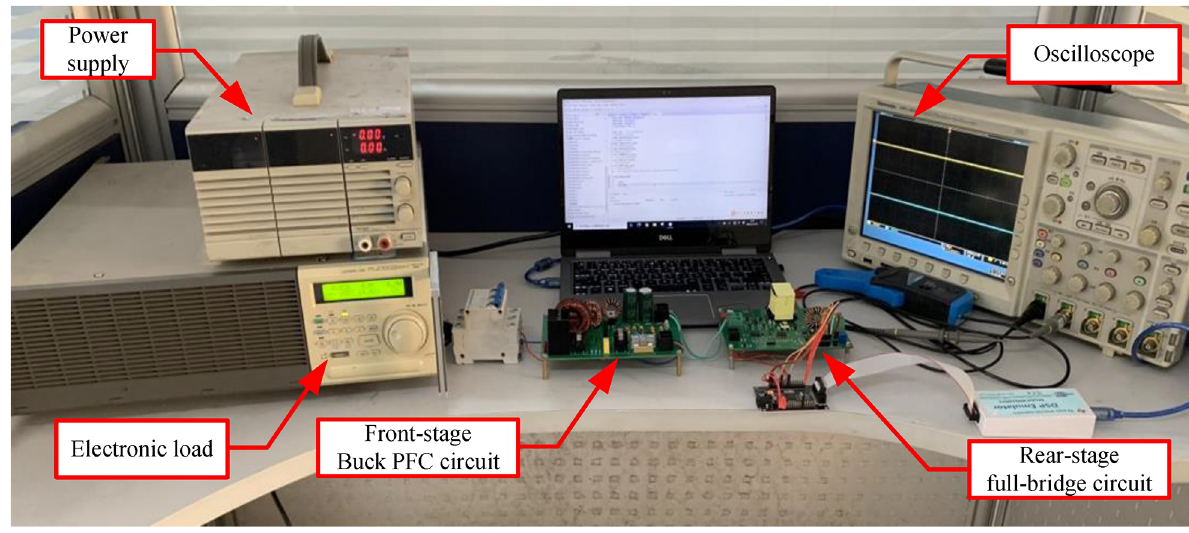
Fig 13. Prototype platform of two-stage AC/DC converter.